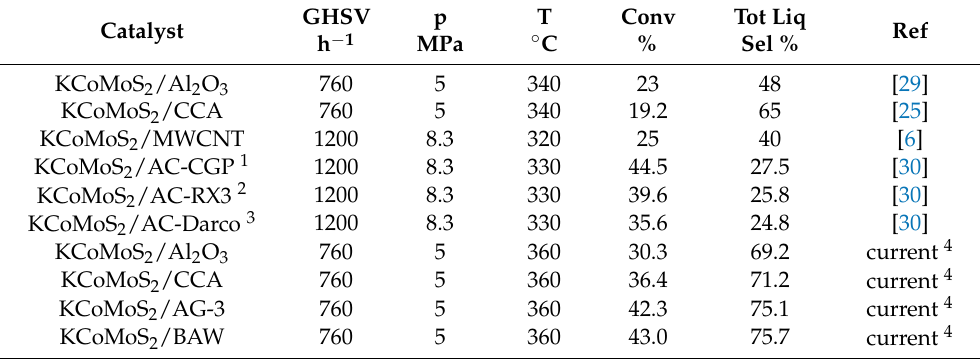
Figure 4. Chain growth factors α i at 360 °C for steps i = 1, 2, 3, 4 over the KCoMoS 2 catalysts sup- ported on Al 2 O 3 , CCA, AG-3 and BAW.